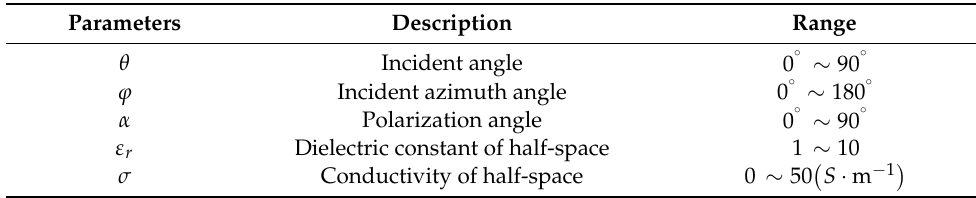
Table 1. Value range of input data.